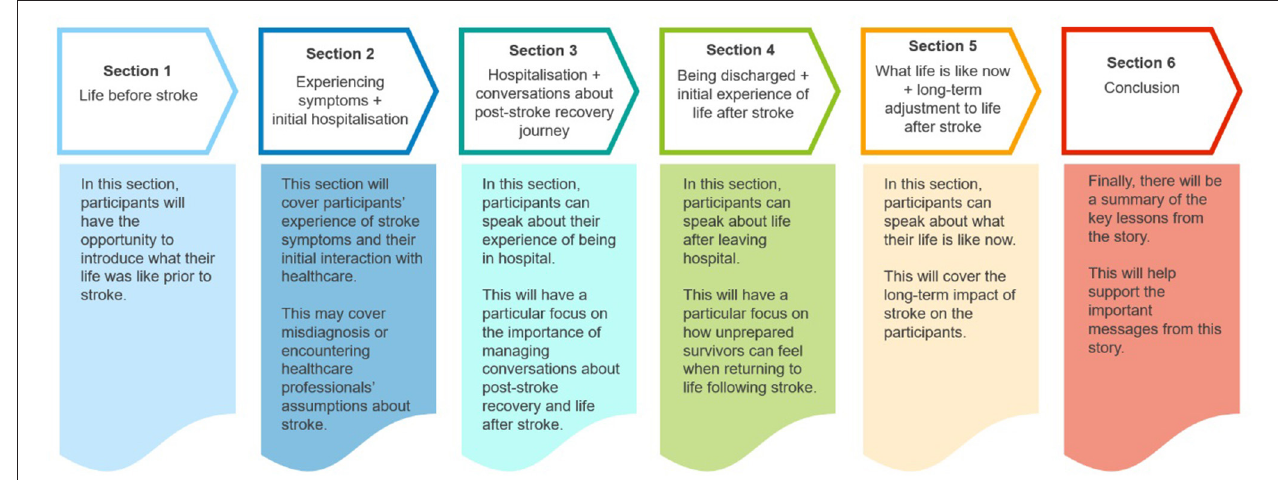
FIGURE 1 | Co-created framework for digital